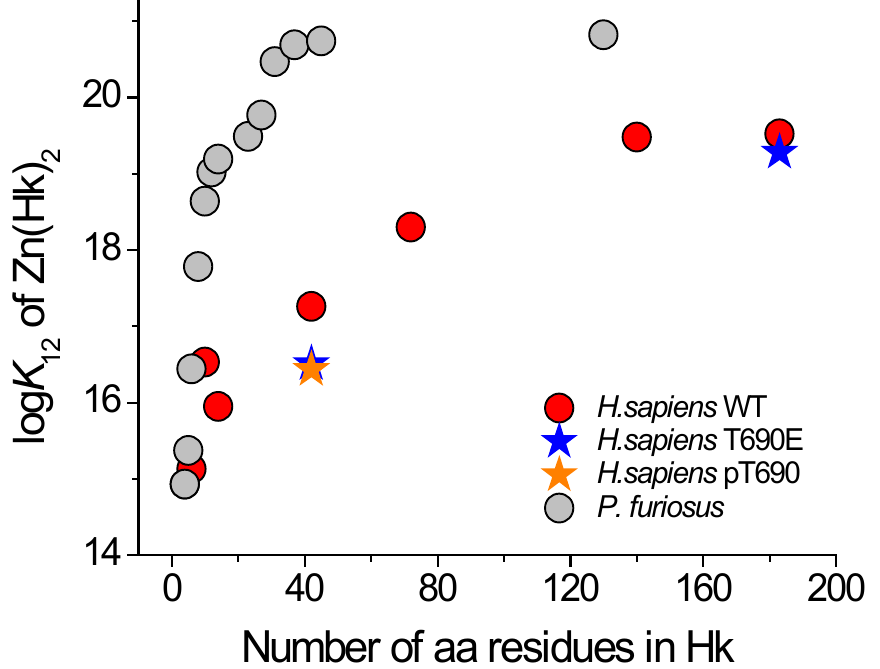
Figure 5. Dependence of conditional formation constants (log K 12 ) of Zn( Pf Hk) 2 (gray circles) and Zn( Hs Hk) 2 (red circles) complexes at pH 7.4 on the length of zinc hook peptides [15,27]. Orange and blue stars correspond to T690E and pT690, respectively.